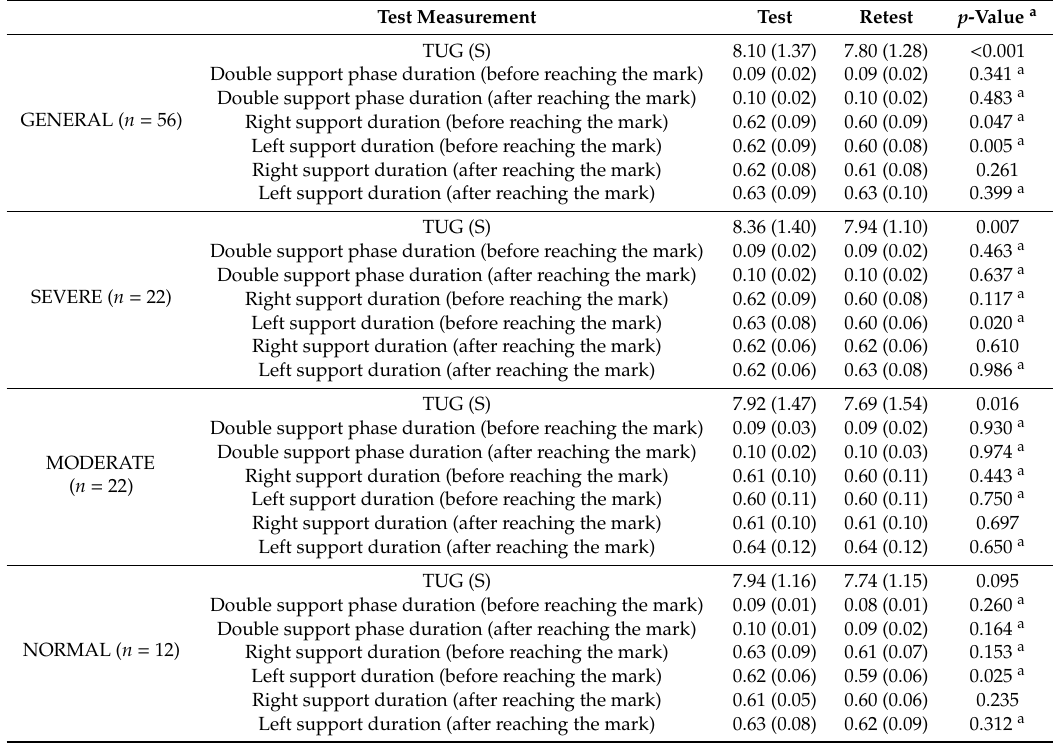
Table 2. Di ff erences between test and retest on the duration of the walking phases in the entire sample and in participants with (a) severe neuropathy, (b) moderate neuropathy and (c) normal